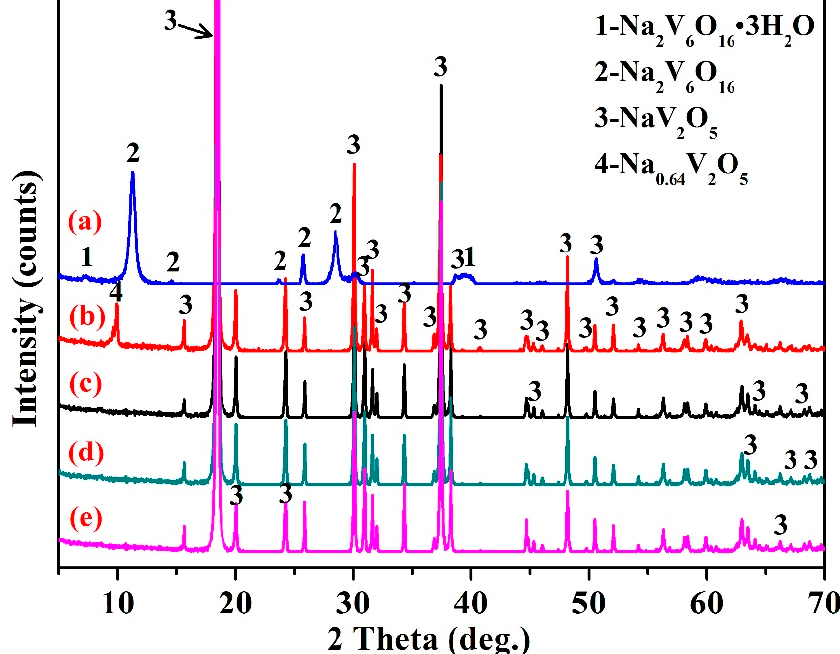
Figure 6. The phase compositions of the products obtained at ( a ) 150 °C, ( b ) 175 °C, ( c ) 200 °C, ( d ) 225 °C, and ( e ) 250 °C under an initial solution pH value of 4, a H 2 gas partial pressure of 4 MPa, and a reaction time of 2 h.